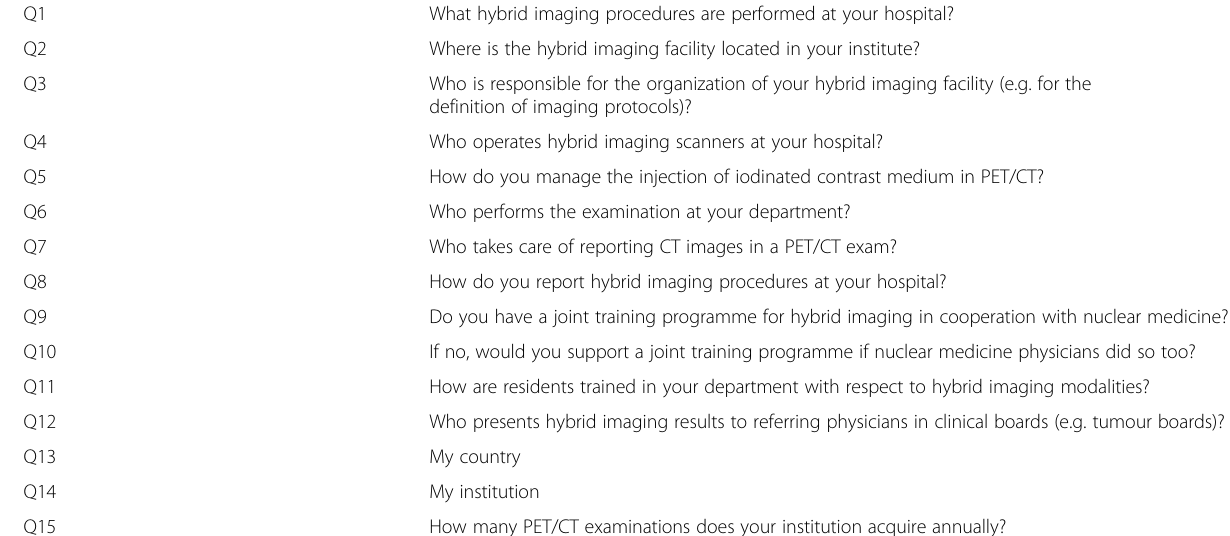
Table 1 Questions of the LOCAL